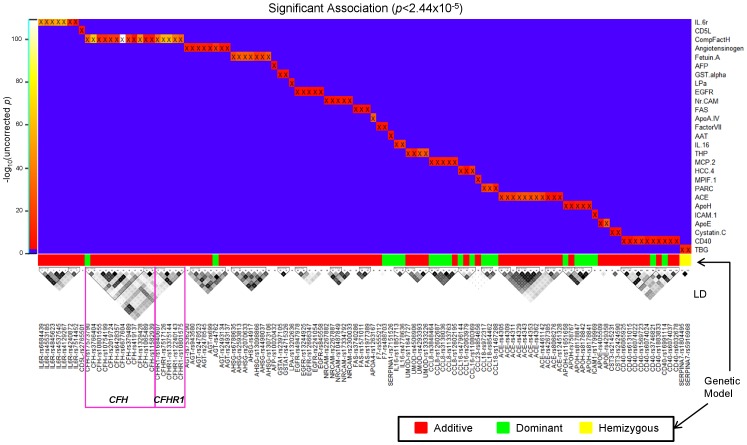
Heatmap of significant associations with genetic models and linkage disequilibrium (LD) in the ADNI cohort.Analyses identified 112 significant (uncorrected p<2.44×10−5) associations, shown as a heatmap. -log10(uncorrected p) was color-coded using the color bar on the left. Below the heatmap (x-axis), tested genetic models and the LD structure within each gene is displayed. Associations of TBG with SERPINA7 SNPs were significant only for males.